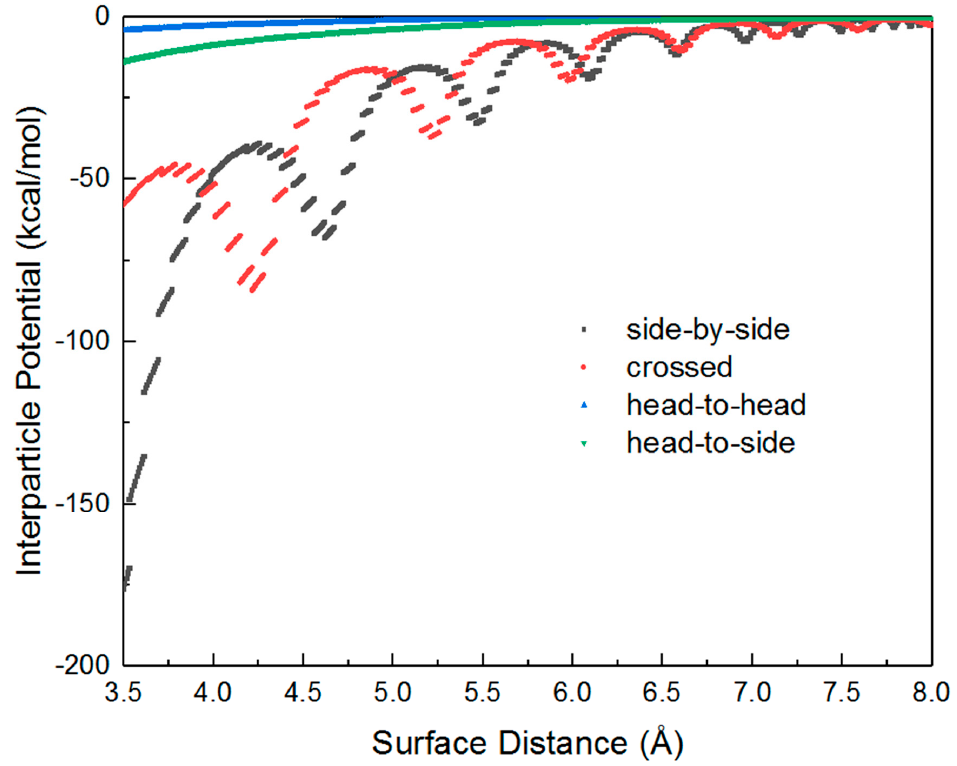
Figure 9. Interparticle potential as a function of surface separation of a pairwise AuNRs with a of 2 nm and aspect ratio of 4 of four typical configurations: side-by-side (in black), crossed (in red), diameter of 2 nm and aspect ratio of 4 of four typical configurations: (a) side-by-side (in black), (b) head-to-head (in green), and head-to-side (in crossed (in red), (c) head-to-head (in green), and (d) head-to-side (in blue).